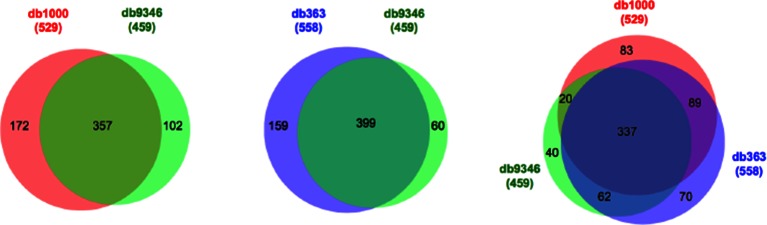
Comparison of identified cross-links using databases of different size.db9346, containing all the proteins identified in the sample; db1000, containing the top 1000 abundant proteins; db363, containing all the proteins for which intra-molecular cross-links had been identified. Filtering criteria: FDR < 5%, E-value < 0.01, and spectral count ≥ 3.